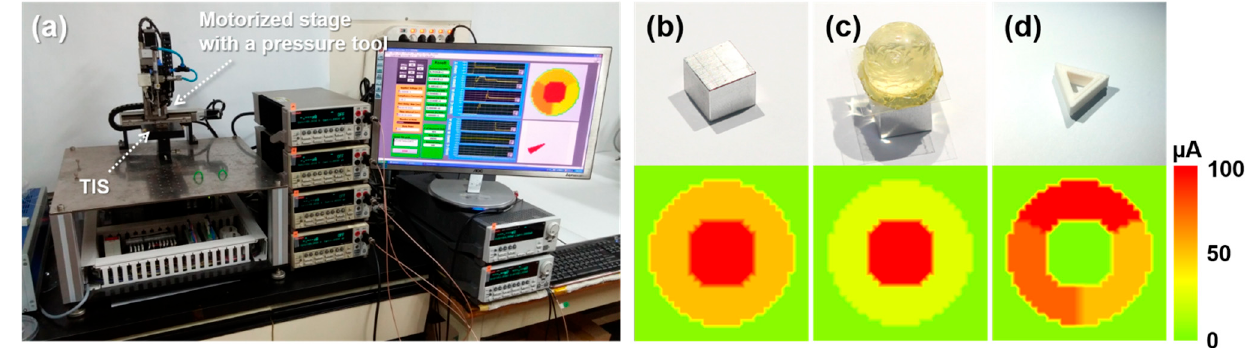
Figure 6. The output characteristics of the TIS during sensing operation: ( a ) the measurement set-up; the current contour map of pressure sensor units when ( b ) box, ( c ) sphere, and ( d ) hollow triangle objects pressed on the TIS.